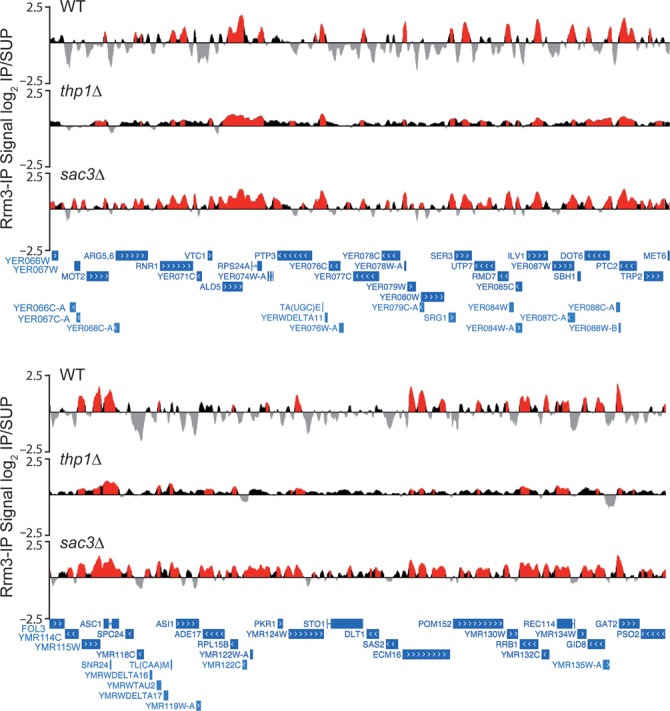
Genome-wide Rrm3 recruitment in thp1Δ and sac3Δ cells. Analysis of Rrm3-FLAG binding to the whole genome by ChIP-chip. Two genomic fragments from chromosomes V and XIII are shown, with enrichment values represented as the signal log2 IP/SUP ratios. Red histograms (online version) represent the significant Rrm3 binding clusters (P < 0.01, minimum run >100 bp, maximum gap <250 bp). Genes and other features are represented according to the SGD.